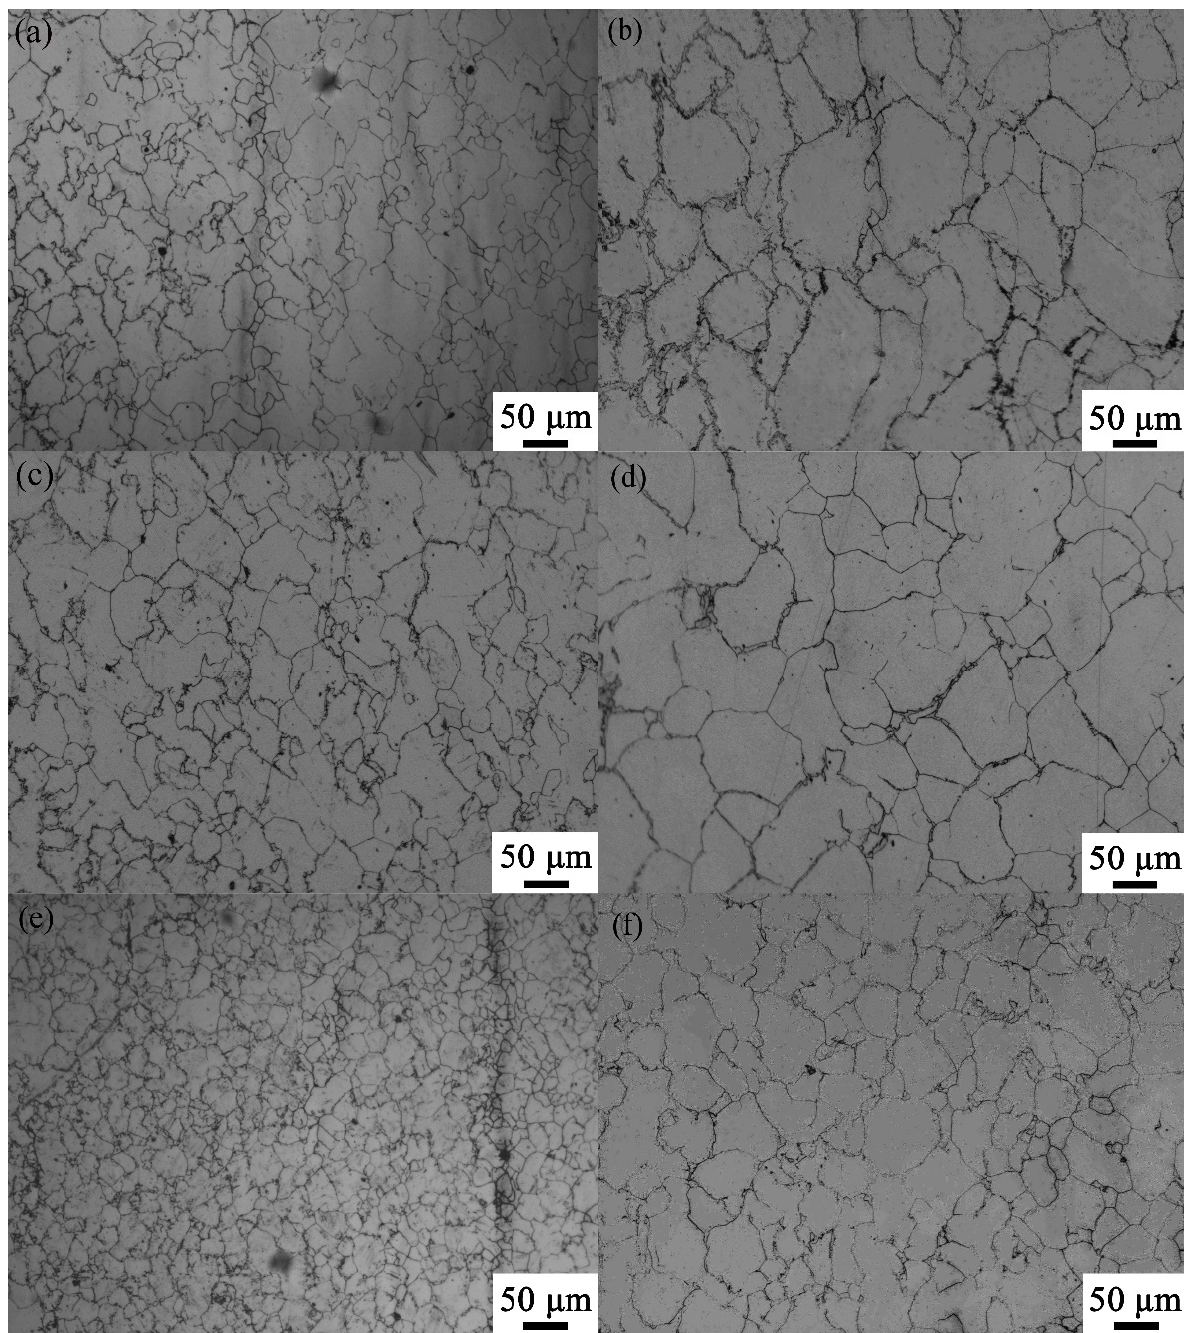
Figure 15. Austenite grain structures of bimetallic specimens after hot deformation at ( a ) 1050 °C, 0.05 s − 1 , ( b ) 1150 °C, 0.05 s − 1 , ( c ) 1050 °C, 0.5 s − 1 , ( d ) 1150 °C, 0.5 s − 1 , ( e ) 1050 °C, 1 s − 1 , and ( f ) 1150 °C, 1 s − 1 . Figure 16a,b show the microstructures of bimetallic specimens deformed under insta- bility region, corresponding to bimetallic specimens compressed at 1150 ◦ C, 5 s − 1 and